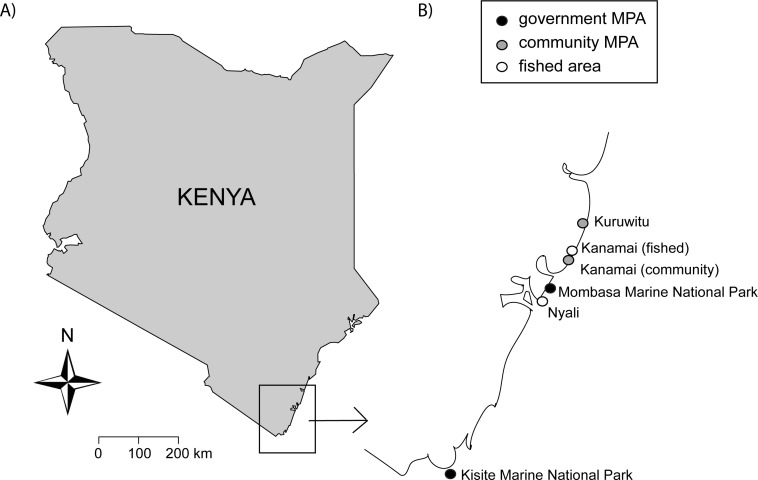
Map of study region.A) Map of Kenya (land in grey), noting the position of the study area in the rectangle. B) The southern Kenyan coastline, marking the positions of the six study areas with black, grey and white dots, respectively.